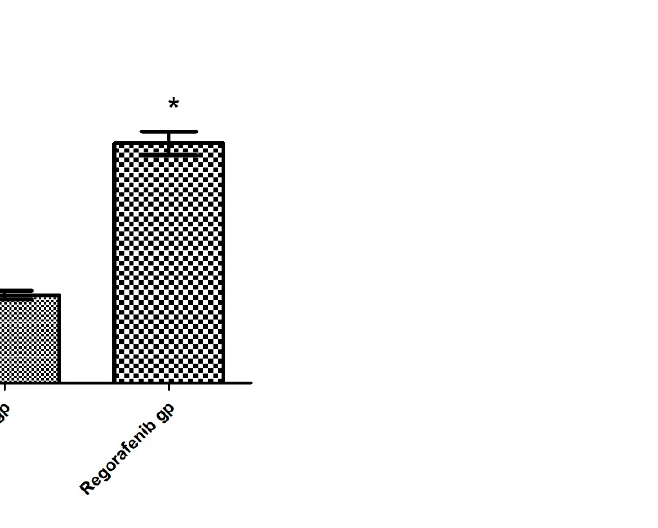
Figure 8. Caspase 3 activity (pg/mL) in regorafenib-treated and vehicle-treated groups. * Significant from control group at p < 0.05.